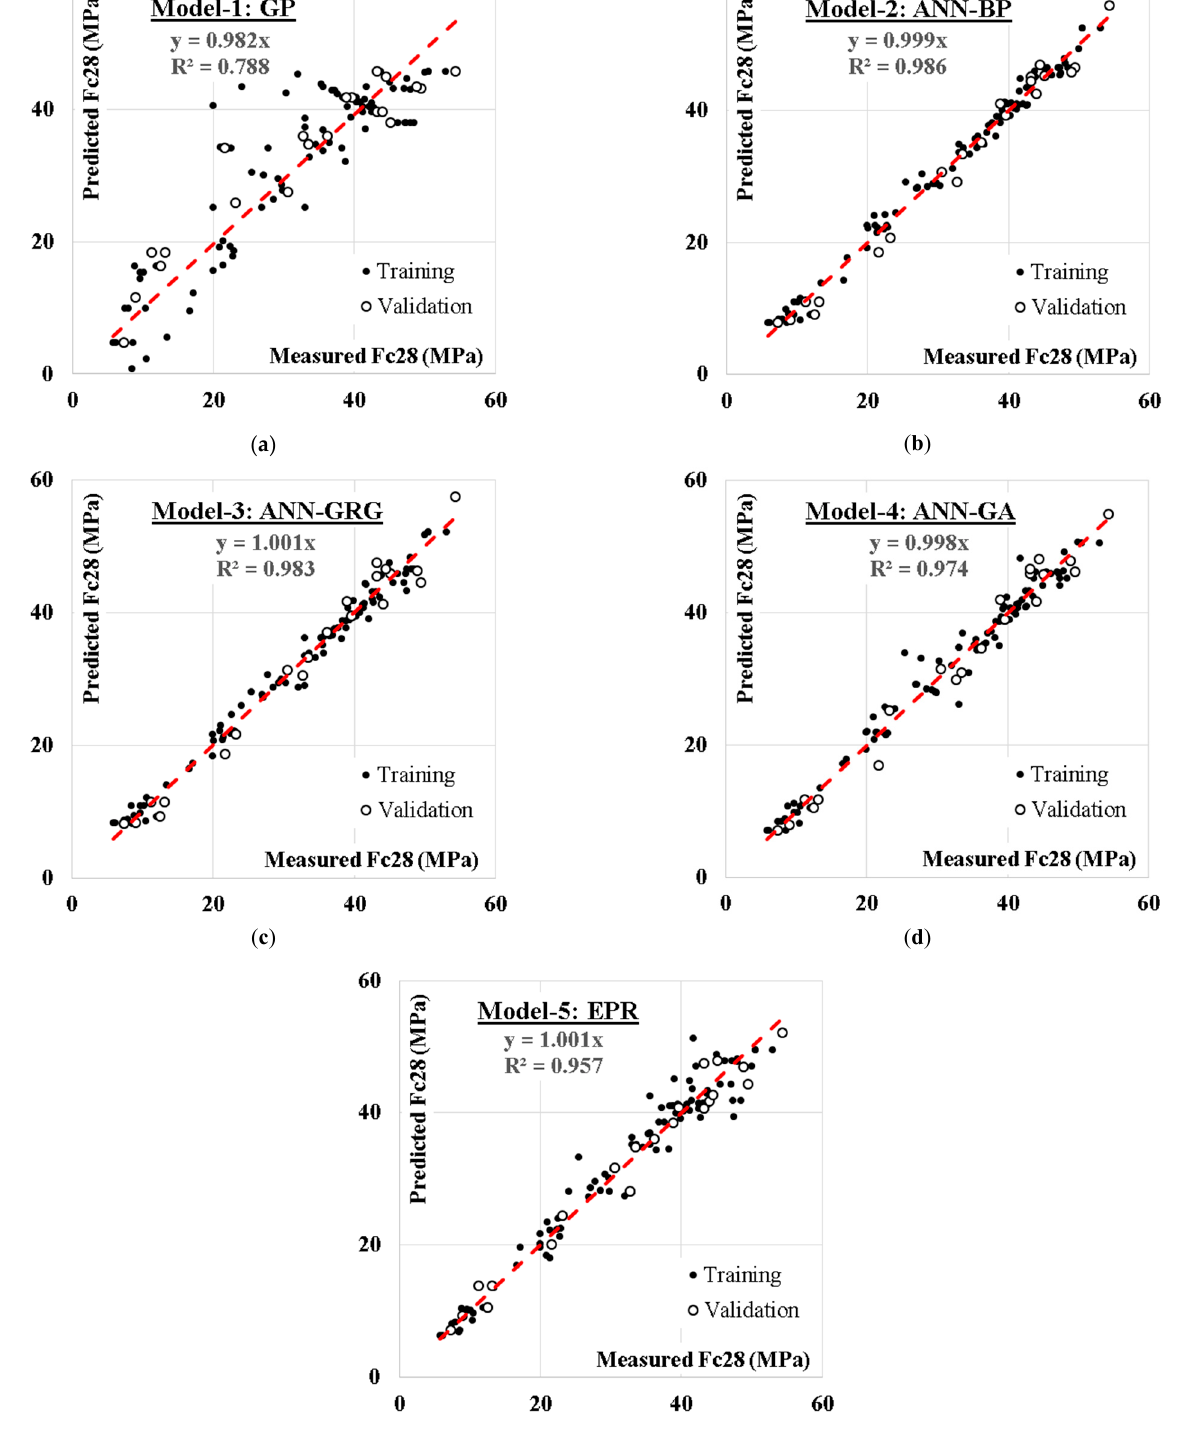
Figure 8. Relation between predicted and calculated Fc28 values using the developed models. ( a ) Model-1: GP; ( b ) Model-2: ANN-BP; ( c ) Model-3: ANN-GRG; ( d ) Model-4: ANN-GA; ( e ) Model-5: EPR.